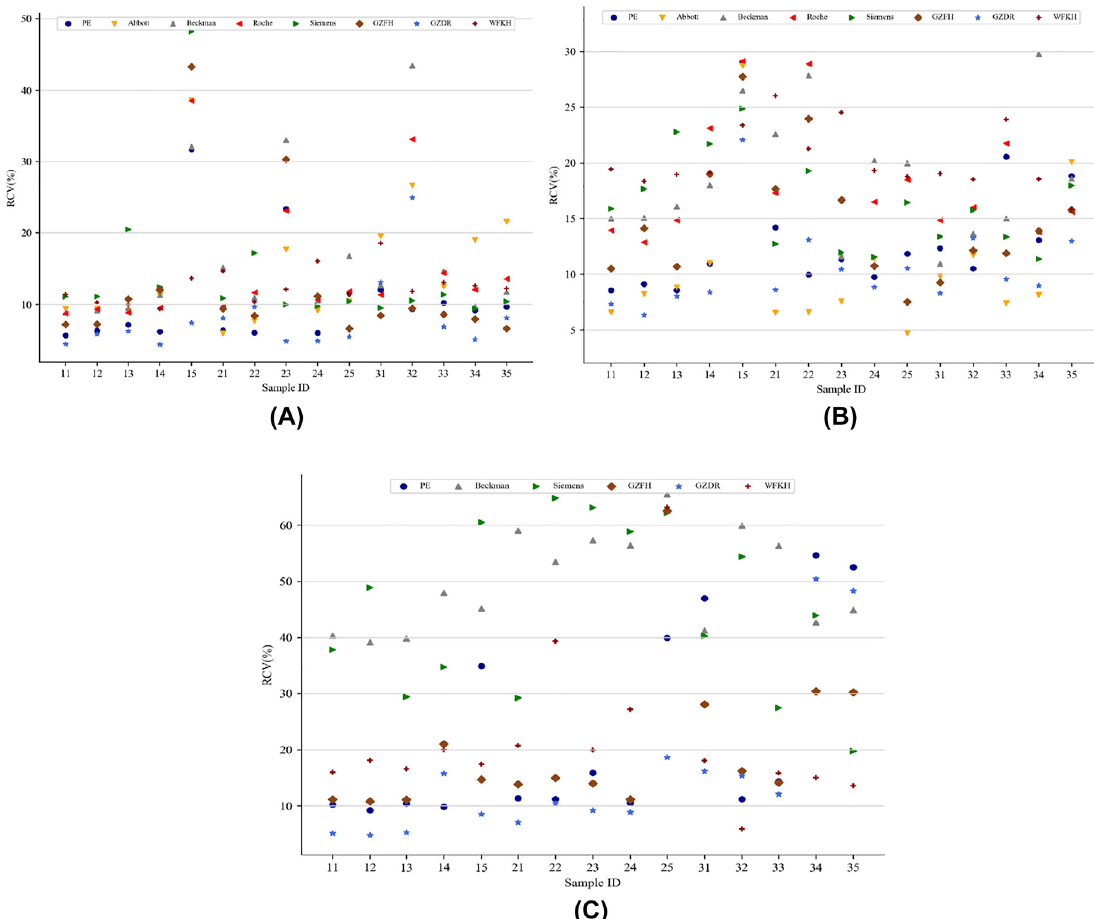
Figure 3: The RCV of each sample for MoM values of AFP, hCG, and uE3 in different platforms. (A) AFP MoM. (B) hCG MoM. (C) uE3